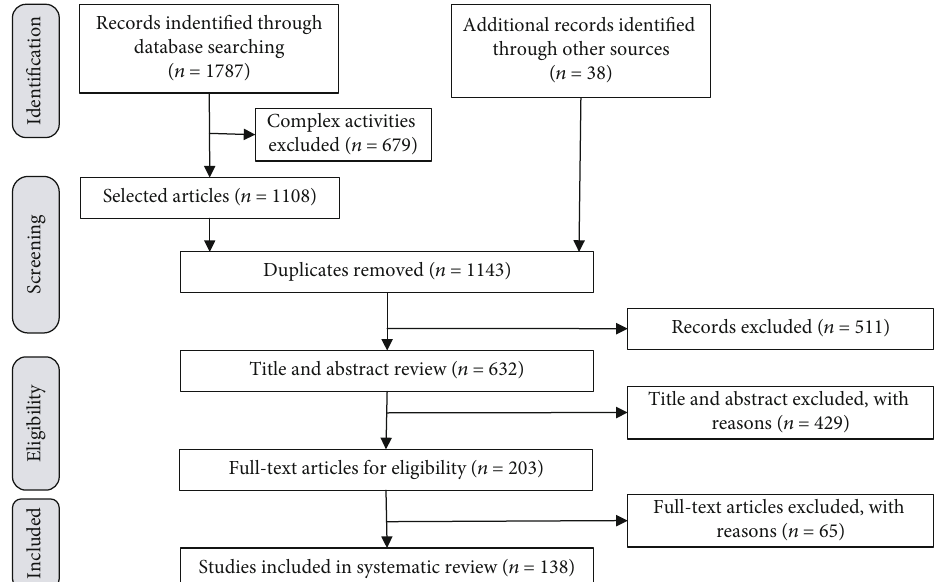
Figure 1: The PRISMA fl ow diagram of study selection